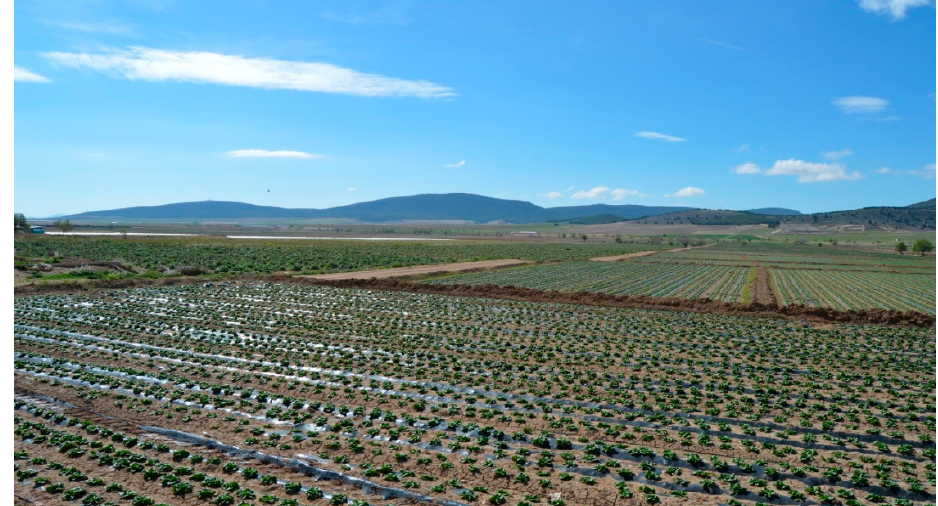
Figure 5. Old agricultural area of a traditional vegetable plot conditioned for the intensive cultivation of lettuce and broccoli. Archivel, Caravaca de la Cruz. Source: Authors.